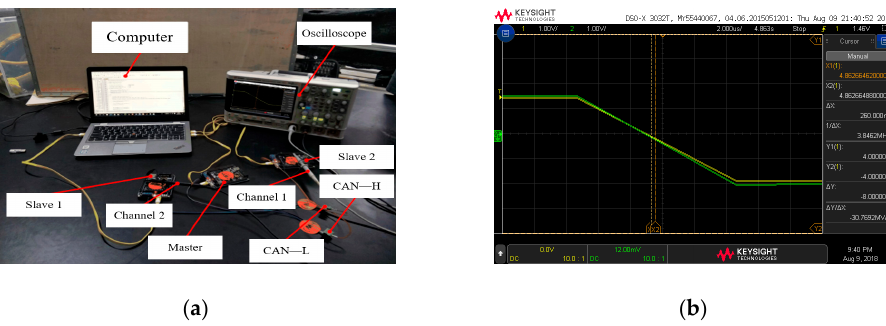
Figure 16. ( a ) The test for time deviation of the response between the two slaves to the trigger signal of the master; ( b ) One of the results.